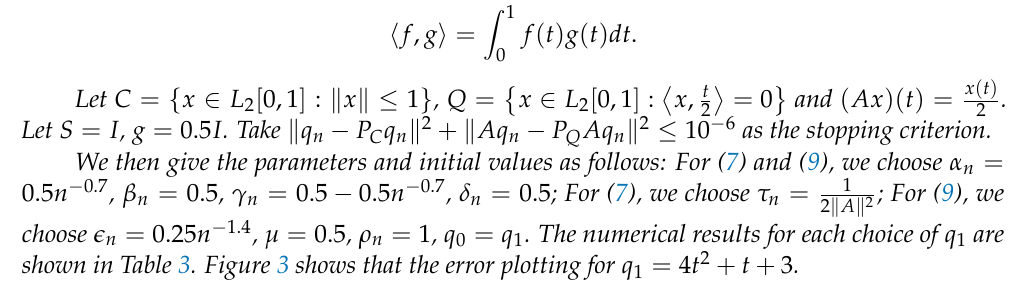
Table 3. Numerical results of scheme (9) and scheme (7) as regards Example